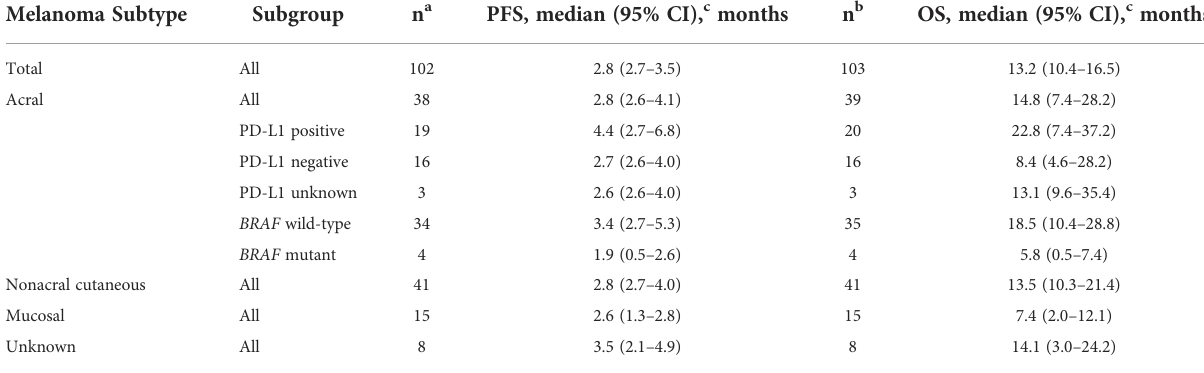
TABLE 4 PFS per RECIST v1.1 by BICR a and OS b